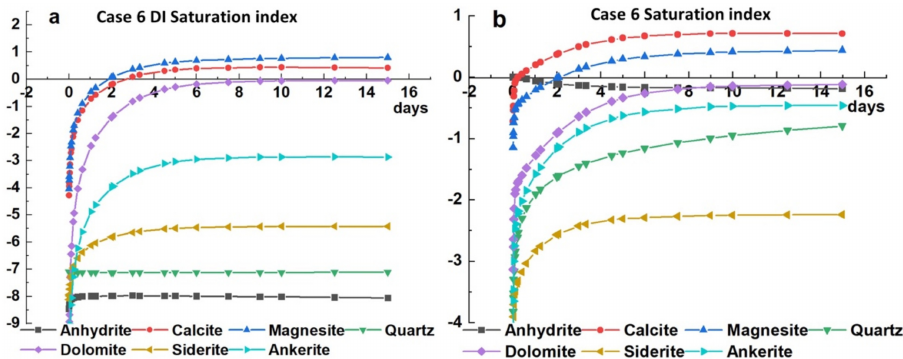
Figure 11. Variations of mineral saturation indexes in the first 15 days: ( a ) Case 6 DI; ( b ) Case 6.